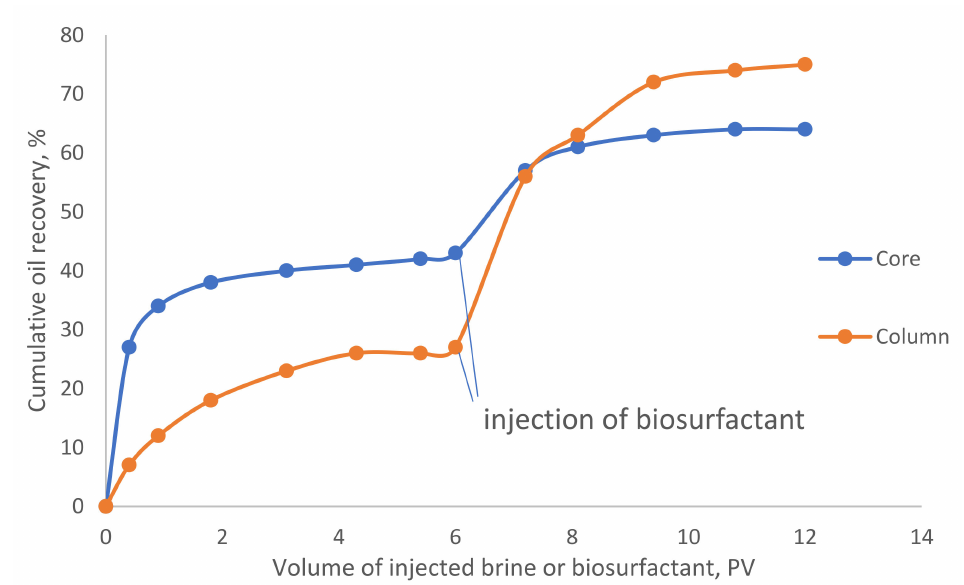
Figure 6. Secondary (before biosurfactant injection) and enhanced (after biosurfactant injection) oil recovery as estimated in sand-packed column and core flooding